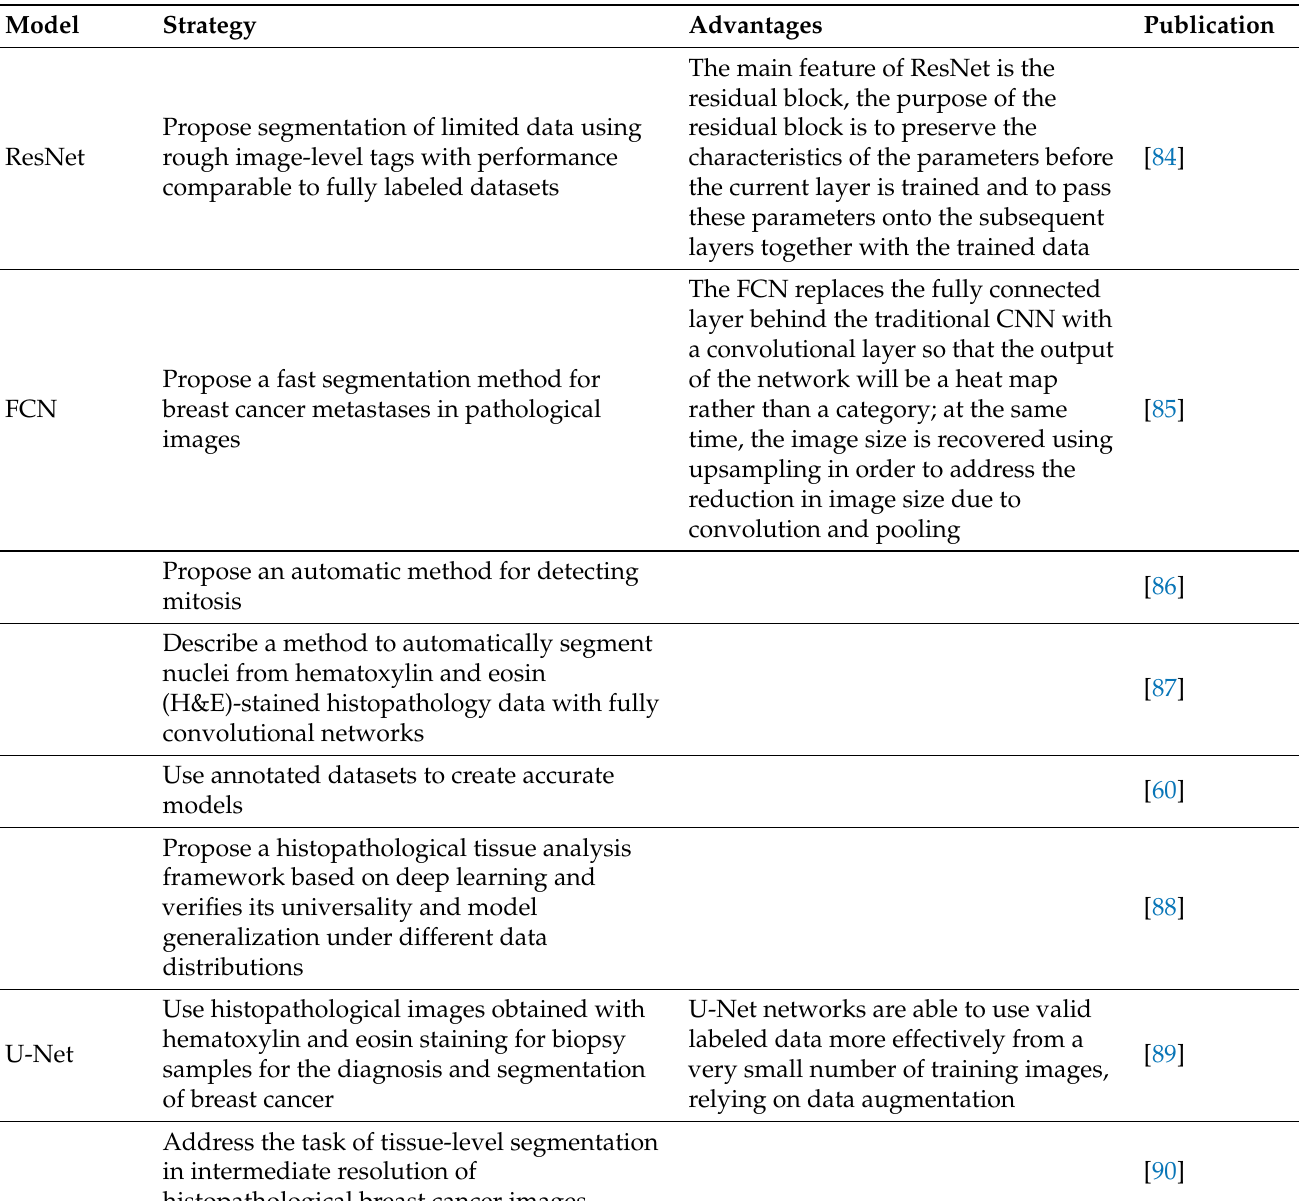
Table 3. Summary of the application of deep learning algorithms in breast cancer histopathology for